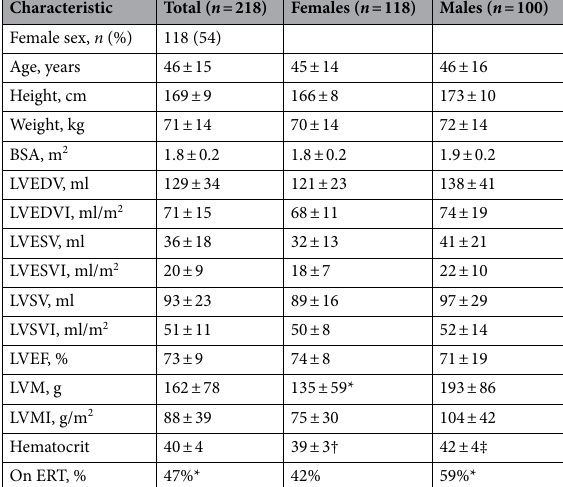
Table 1. Baseline characteristics of FD patients. Data presented as mean ± SD. BSA body surface area, ERT enzyme replacement therapy, LVEDV left ventricular end diastolic volume, LVESV left ventricular end systolic